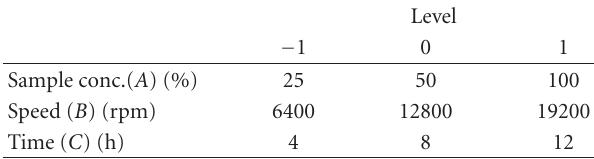
Table 2: 3 ∗∗ (3-1) Fractional Factorial Design for High-Speed